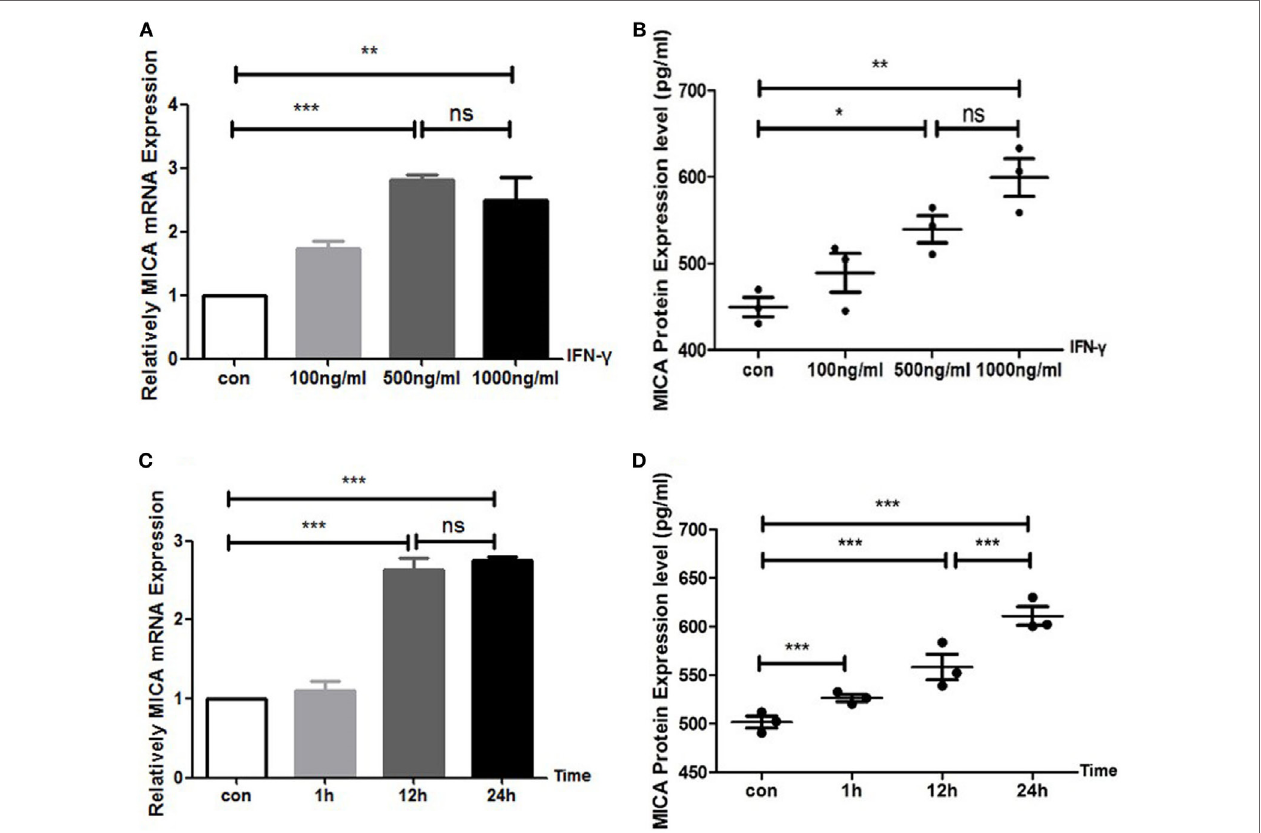
FigUre 1 | IFN- γ increases MICA expression levels in human corneal epithelial cells. (a) RT-PCR analysis of MICA mRNA expression and (B) enzyme-linked immunosorbent assay analysis of the MICA protein expression levels after IFN- γ treatment for 24 h. (c) The expression of MICA mRNA and (D) protein in cells treated with 500 ng/ml IFN- γ . Data are shown as the mean ± SD. * p < 0.05; ** p < 0.01; *** p < 0.001 vs. untreated control. Con, control; ns, not significant.